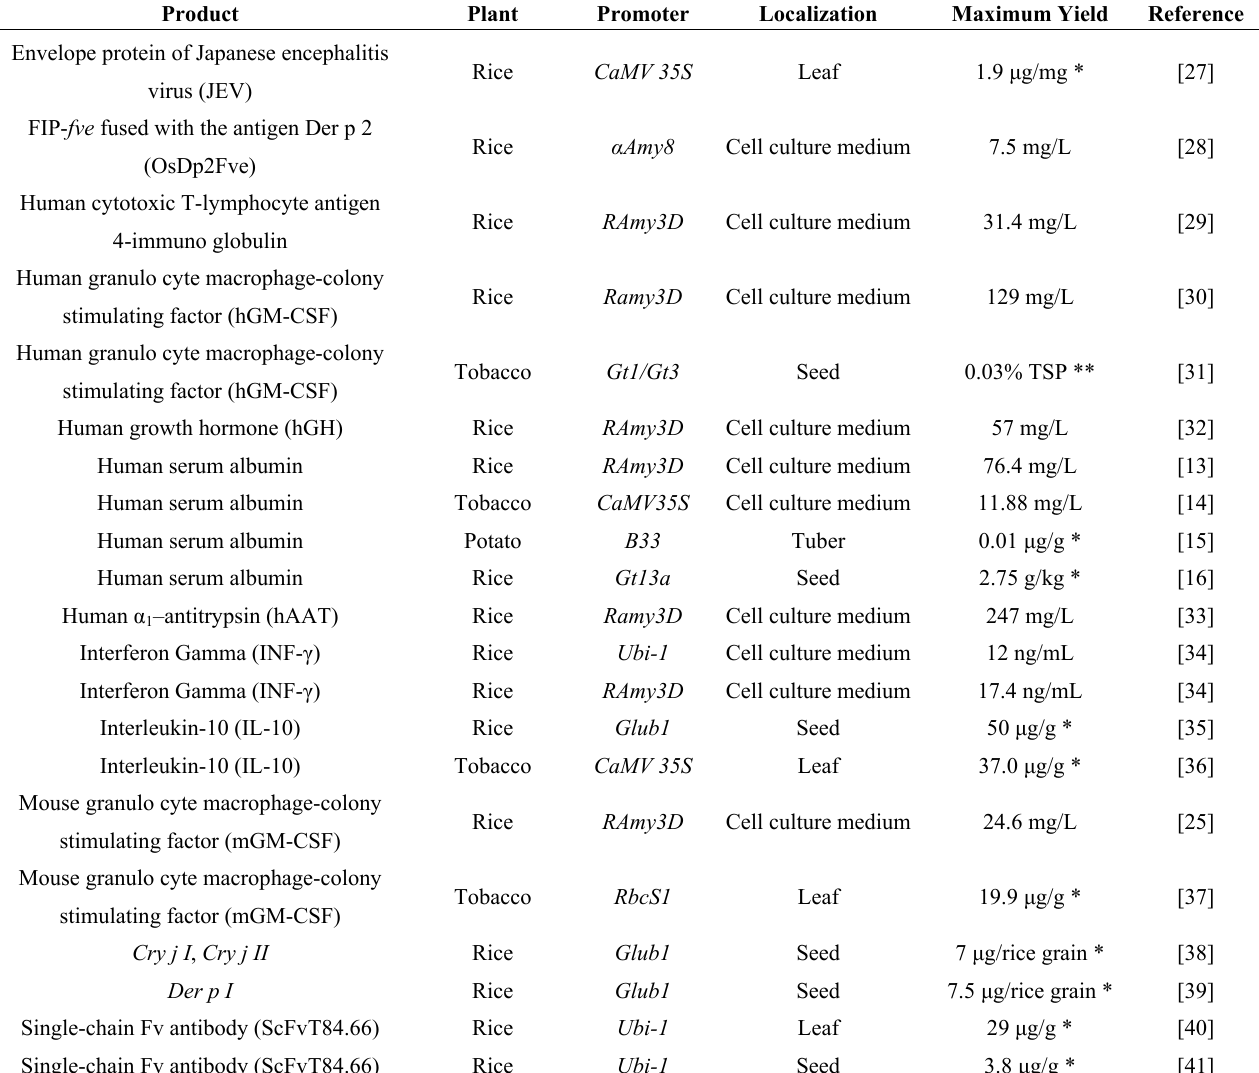
Table 1. Pharmaceuticals produced in rice and yield comparison to other